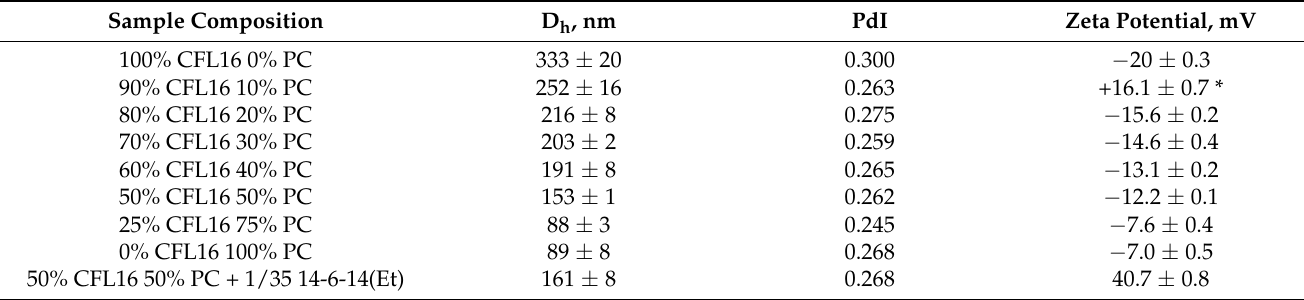
Table 1. DLS characteristics of hybrid cerasomes prepared via thin film hydration with varied composition of lipids and the effect of modification with 14-6-14(Et) on the zeta potential at pH =